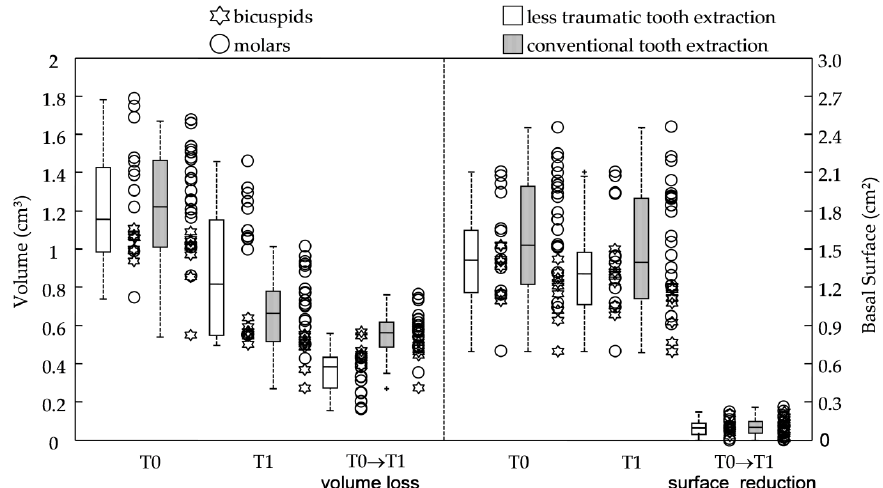
Figure 3. Scatter and box plots for the anatomical variables and outcomes at baseline (T0) and 4month postoperative time (T1) in ltr and con group; volumes V, basal surfaces BS, and their change at 3 months. In the box-and-whiskers plot, the box line represents the lower, median, and upper quartile values, the whisker lines include the rest of the data. Outliers (+) were data with values beyond the ends of the whiskers. Scatter data were ranked by tooth type.